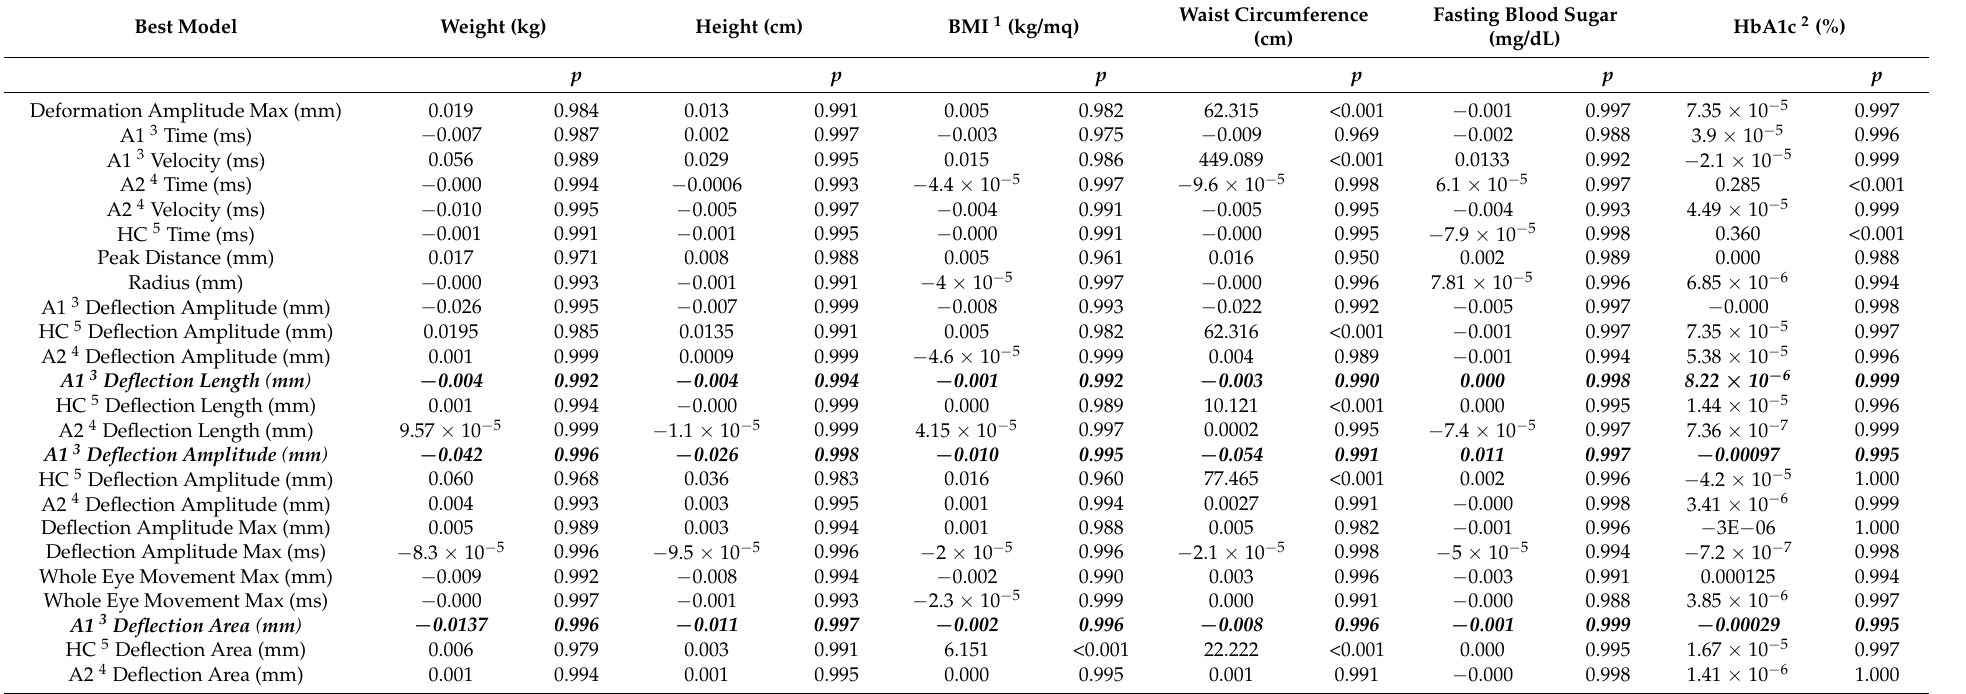
Table 5. Evaluation of correlations among the biomechanical characteristics of MODY2 corneas and the systemic